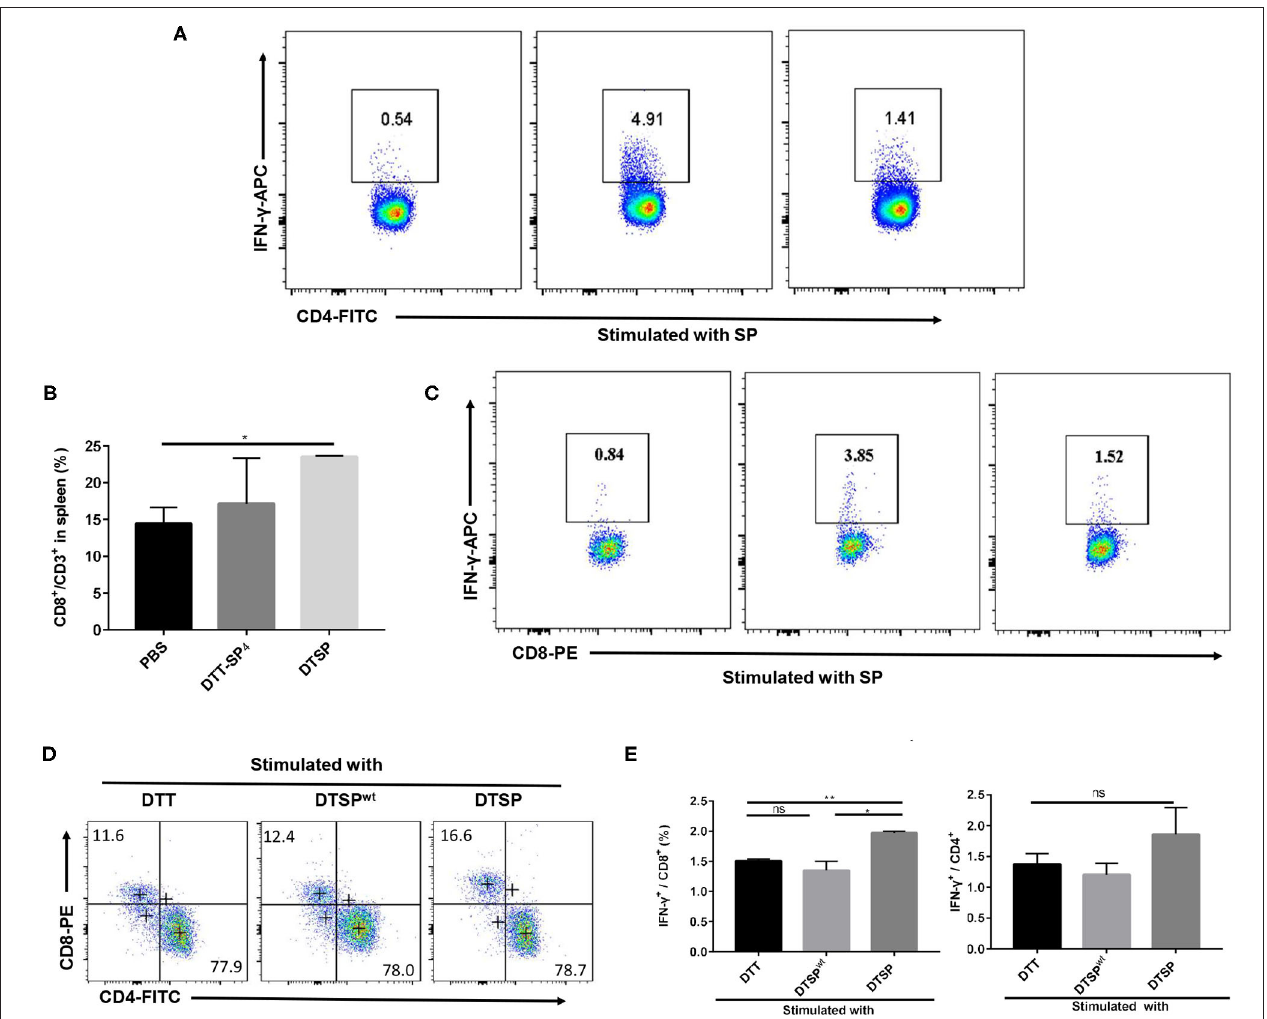
FIGURE 5 | Expression of intracellular antigen-specific IFN- γ in CD4 + or CD8 + T cells. (A–E) Mice were vaccinated with PBS, DTT-SP 4 , or DTSP in combination with Alum and CpG three times at 10-day intervals. Splenocytes ( n = 3) were harvested 7 days after the final immunization. Splenocytes isolated from immunized mice were co-incubated with BMDCs pulsed with indicated antigens for 48h, and blocked by BFA for another 6h. Cells were collected and stained with anti-CD4-FITC, anti-CD8-PE, and anti-CD3-PercP5.5 antibodies. After fixation and permeabilization, cells were stained with anti-IFN- γ -APC antibody and read by flow cytometry. (A–C) Splenocytes isolated from PBS-, DTT-SP 4 -, or DTSP-treated mice were pulsed with 12 µ g/ml SP. CD8-positive cells (B) were gated around CD3 + T cells. Data are presented as means ± SD. * p < 0.05, Student’s t -test. Representative IFN- γ -positive cells in CD4 + T cells (A) and in CD8 + T cells (C) are shown. (D,E) Splenocytes of DTSP-treated mice were stimulated with 50 µ g/ml DTT, DTSP, or DTSP wt ex vivo . (D) The proportions of CD4 + T cells and CD8 + T cells in CD3 + T cells after stimulation are shown. (E) Percentages of IFN- γ -producing CD4 + (right panel) or IFN- γ -producing CD8 + (left panel) T cells after treatment. These data are presented as means ± SD. * p < 0.05, ** p < 0.01, ns, not significant, Student’s t